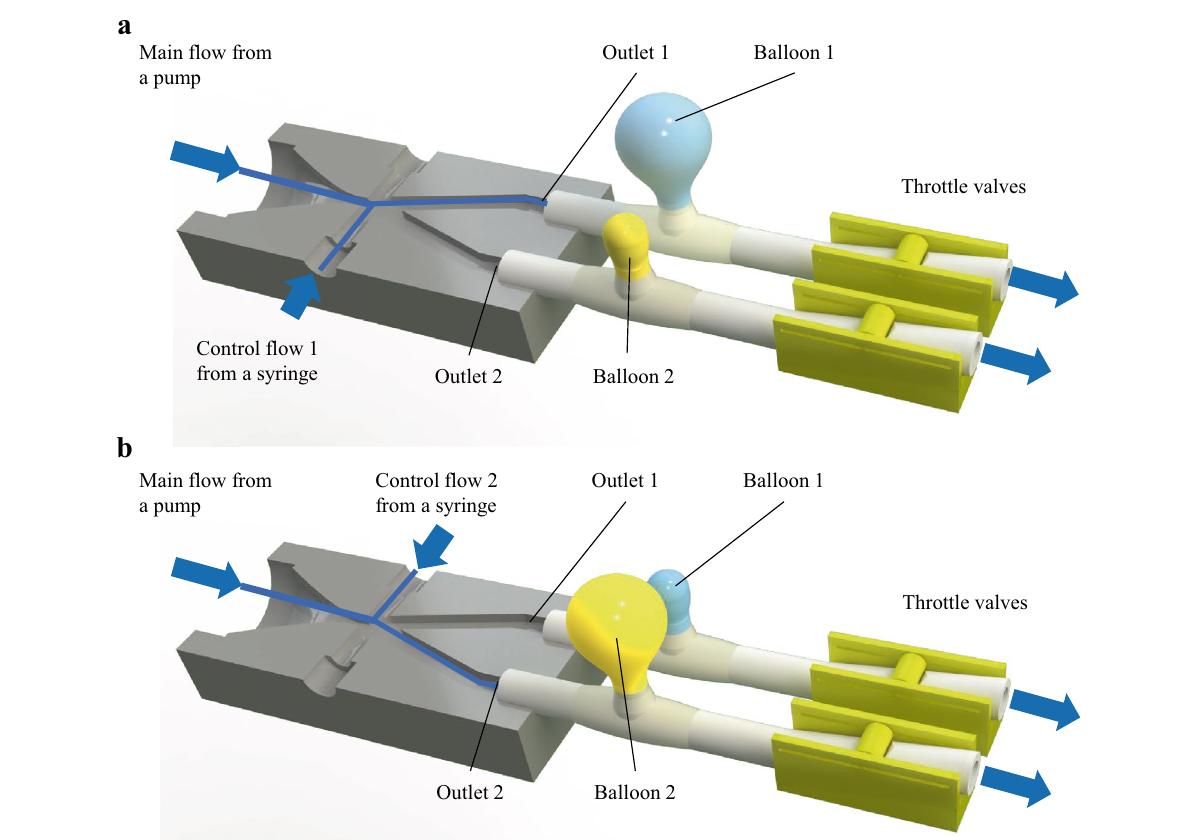
Fig. 1 Overviews of the proposed system to selectively drive balloons with simple fluidics valve mediated with the Coanda effect. a When the control flow 1 is introduced, b when the control flow 2 is